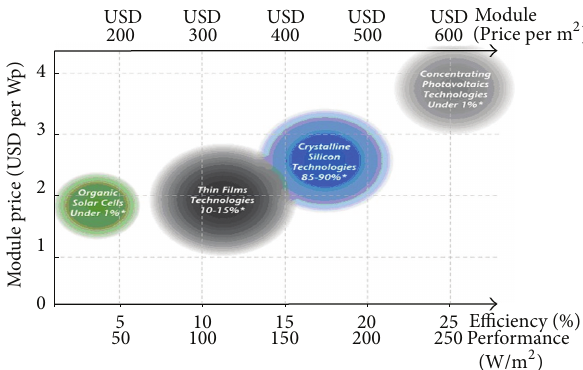
Figure 3: Efficiency and price development for different PV module technologies in 2010 [10].